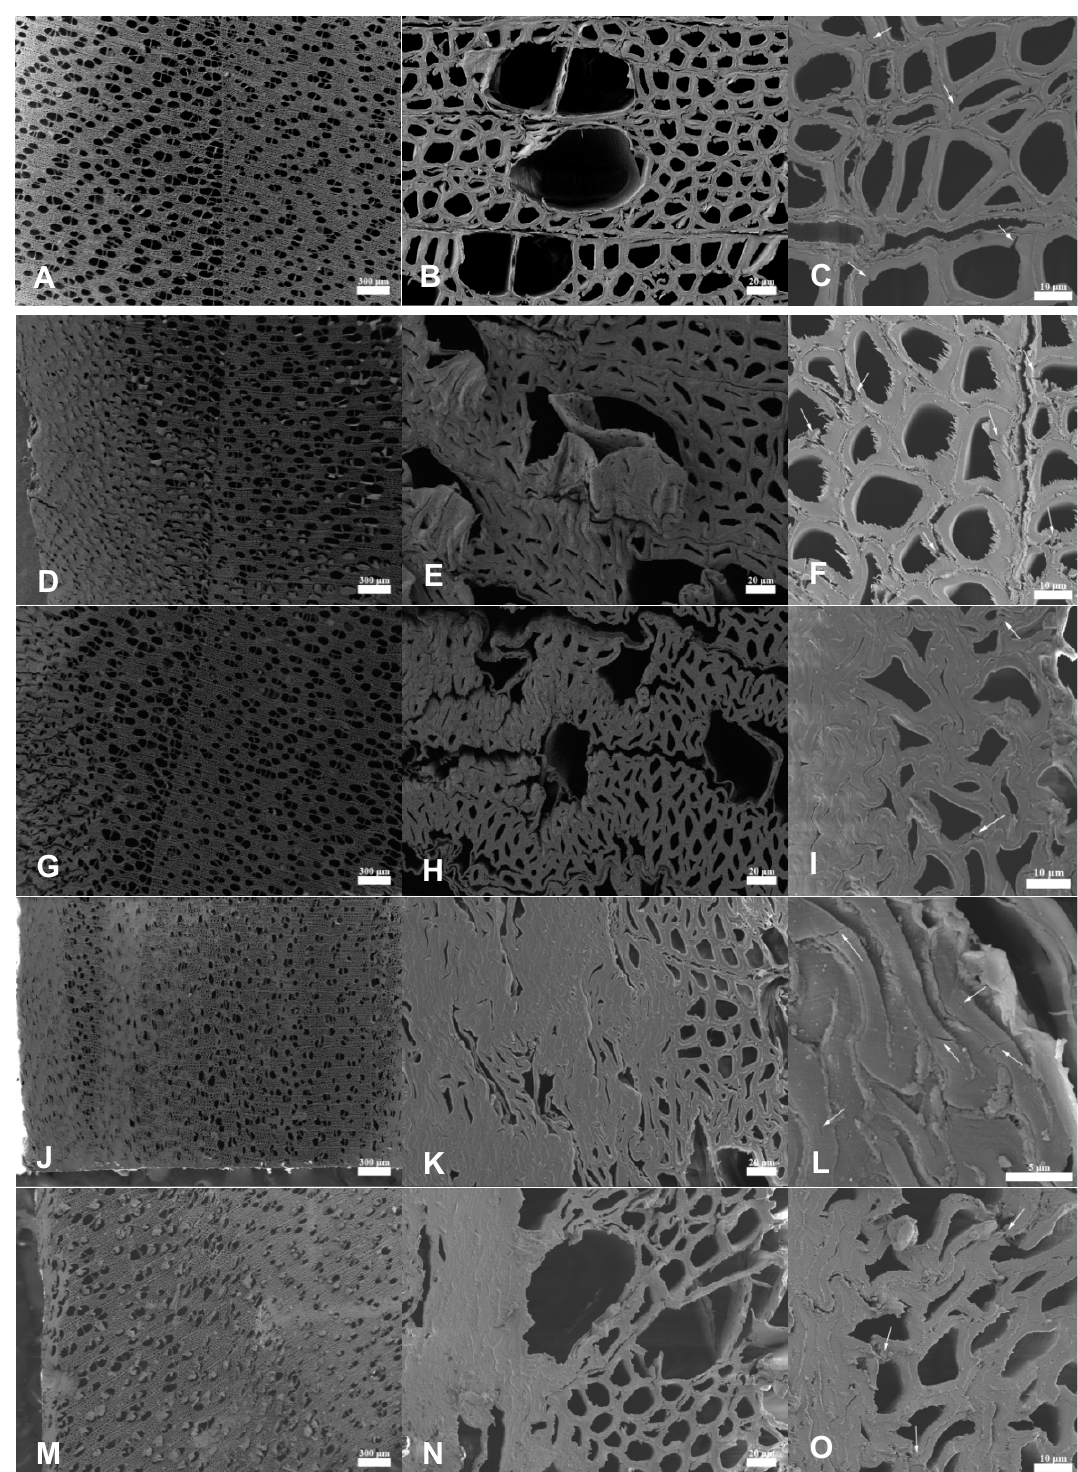
Figure 2. The SEM images showing wood cell microstructures: ( A – C ) untreated wood; ( D – F ) A0 ; ( G – I ) A2 ; ( J – L ) A2N ; and ( M – O ) M50 . Left column: scale bars = 300 μ m; middle column: scale bars = 20 μ m; right column: scale bars = 10 μ m, except L = 5 μ m.